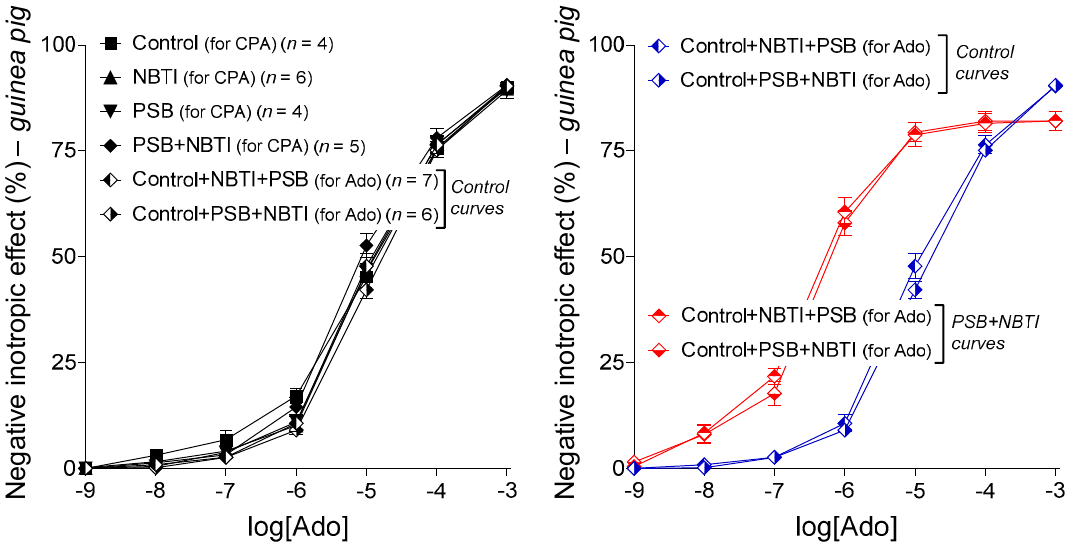
Figure 5. The direct negative inotropic effect of adenosine in the isolated guinea pig left atrium, in the absence of any chemicals affecting the adenosinergic homeostasis (for all groups) and in the presence of PSB-12379 together with NBTI (for the groups labeled with “for Ado”). The left panel denotes the first adenosine E/c curve of all groups (for the groups labeled with “for CPA”, this is the only adenosine E/c curve, while in the case of the groups labeled with “for Ado”, this is the so-called control curve). Atria producing the first adenosine E/c curve were handled uniformly, so the group names refer to subsequent in vitro treatments. The right panel presents the first and third adenosine E/c curves of the groups labeled with “for Ado” separately. The x -axis shows the common logarithm of the molar concentration of adenosine (in the bathing medium), and the y -axis denotes the effect (as a percentage decrease in the initial contractile force). The sym- bols indicate the responses to adenosine averaged within the groups (± SEM). The color code used for the E/c curves in the right panel is the same as seen in Figure 6 (blue and red colors refer to the absence and presence of PSB-12379, respec- tively). Kind of E/c curves provided by groups labeled with “for Ado” is indicated in italics. E/c: concentration–effect; Ado: adenosine; CPA: N 6 -cyclopentyladenosine; NBTI: S -(2-hydroxy-5-nitrobenzyl)-6-thioinosine; PSB-12379: disodium N 6 -benzyl- α , β -methyleneadenosine-5’-diphosphate. 2.3.2. Response to CPA in the Groups Labeled with “for CPA” CPA, a selective, synthetic A 1 receptor full agonist, also decreased the resting con- tractile force of guinea pig left atria in a concentration-dependent manner. The effect of NBTI was similar to that of NBMPR in the rat atrium and practically the same as our ear- lier results with NBTI in the guinea pig atrium (cf. Figure 6, left panel, Figures 1 and 4, left panel). When added alone, PSB-12379, a selective inhibitor of CD73 with no apparent ef- fect on the A 1 receptor, did not significantly influence the effect of CPA, in contrast to FSCPX. However, PSB-12379 significantly blunted the effect of NBTI on the response to CPA, just as FSCPX did. The only difference between the “anti-NBTI” effects of PSB-12379 and FSCPX was that the former was weaker than the latter (cf. Figure 6, left panel and Figure 1, left panel). 2.3.3. Response to Adenosine in the Groups Labeled with “for Ado” The effect of NBTI was practically the same as that observed in our earlier work (cf. Figure 6, right panel and Figure 1, right panel). Similar to the results with CPA (Figure 6, left panel), PSB-12379, administered alone, did not significantly affect the effect of adeno- sine (Figure 6, right panel). Importantly, also consistent with the results with CPA, PSB- 12379 significantly inhibited the effect of NBTI for the response to adenosine; more pre- cisely, it inhibited the so-called general E/c curve-modifying effect of NBTI (Figure 6). Thus, PSB-12379, when co-administered with NBTI, moderately but statistically signifi- cantly increased the response to adenosine as compared to the adenosine E/c curve gen- erated in the presence of NBTI alone (Figure 6, right panel). Additionally, in line with the